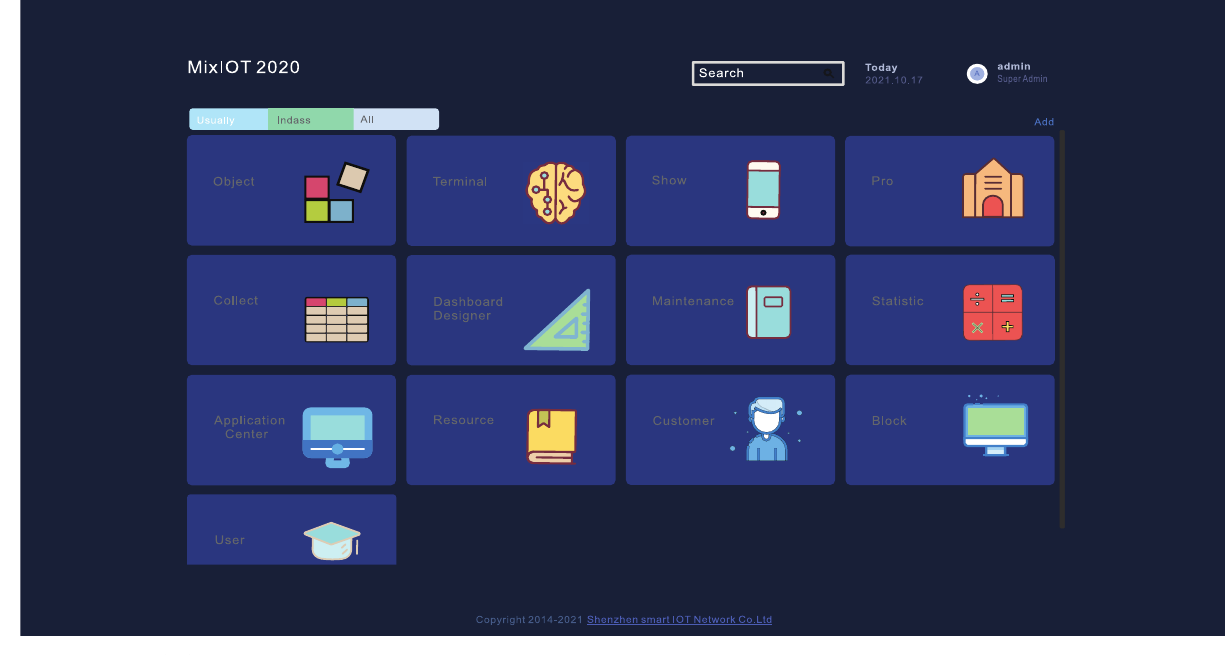
Fig 5. MIXIOT platform.